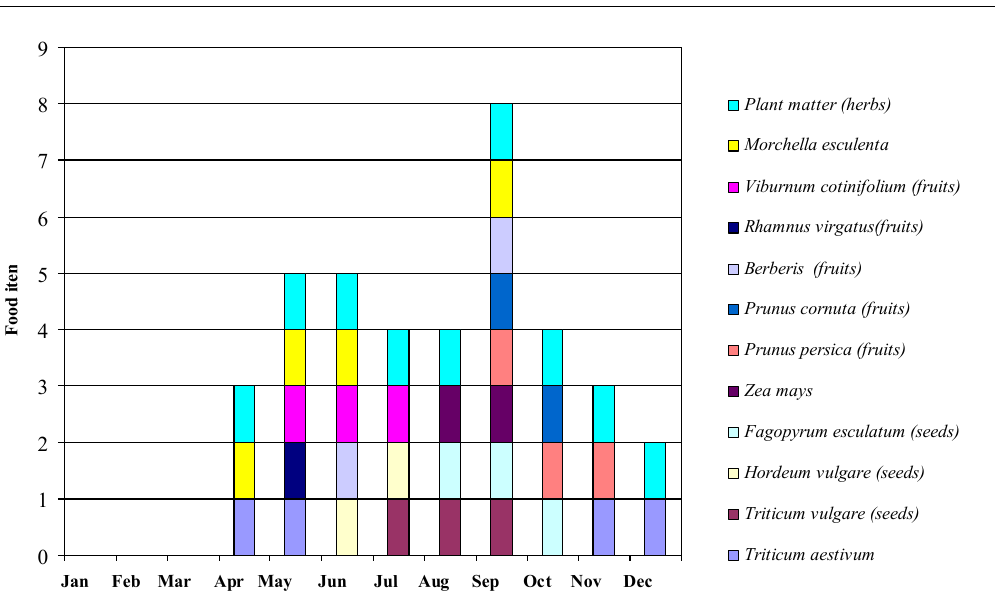
Figure 6. Presence of food items in Himalayan Brown Bear scats in different months in Kugti Wildlife